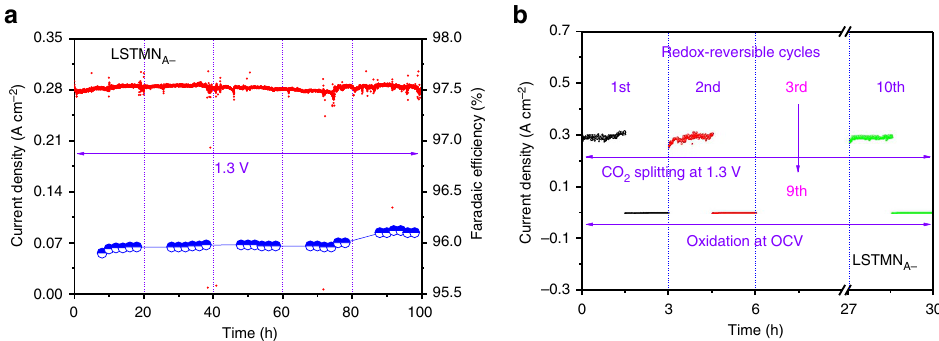
Figure 7 | Cycling performance. ( a ) The long-term performance and current efficiency of the LSTMN A (cid:2) cathode with the flow of CO 2 at 800 (cid:2) C; ( b ) the short-term performance of LSTMN A (cid:2) cathode after 10 redox